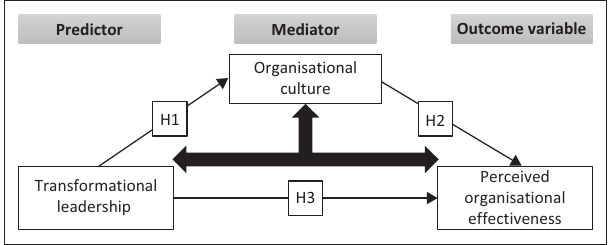
FIGURE 1: Hypothesised relationships and conceptual